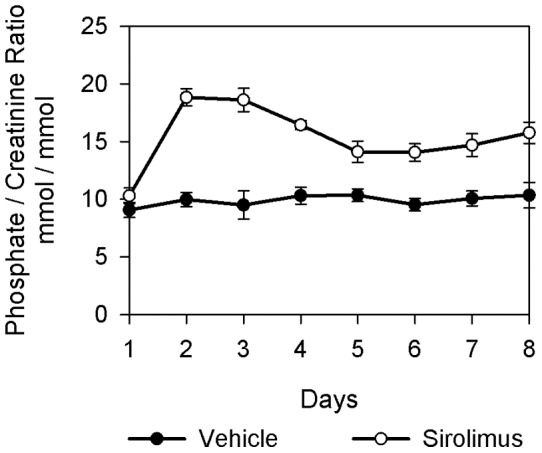
Effect of sirolimus on renal phosphate excretion.Trajectories of urinary phosphate/creatinine ratios of sirolimus and vehicle treated rats. Sirolimus caused statistically significant increased urinary phosphate excretion 24 hours after the first sirolimus injection (day 2) until after seven sirolimus injection (day 8, n = 6 for each group).